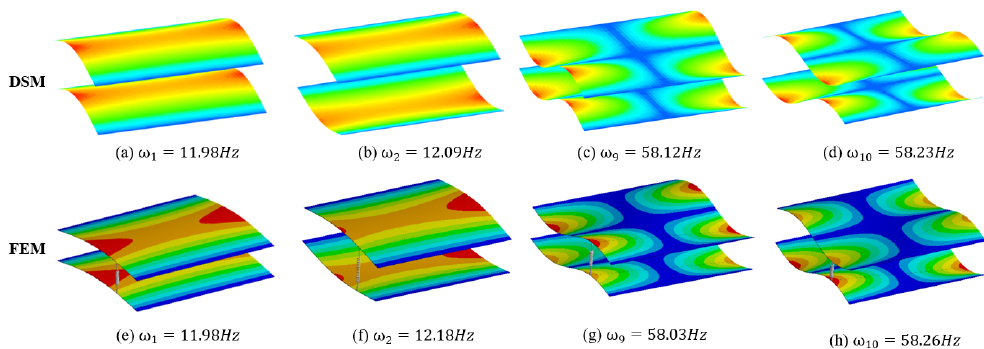
Figure 18. Comparison of the 1st, 2nd, 9th and 10th natural mode shapes of two plates coupled by a spring with K s = 1.2 kN/m as shown in Figure 17a computed by both DSM and FE package ANSYS.